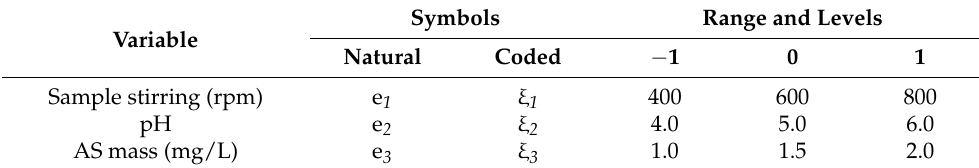
Table 1. Levels of coded and natural parameters range applied in RSM model. Variable